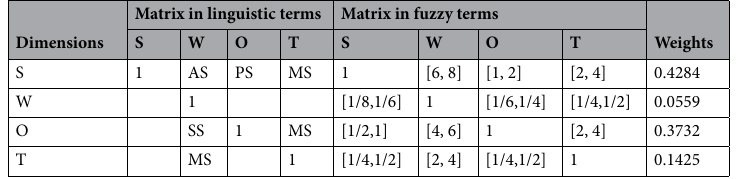
Table 3. Evaluation of SWOT dimensions. (C.R. =